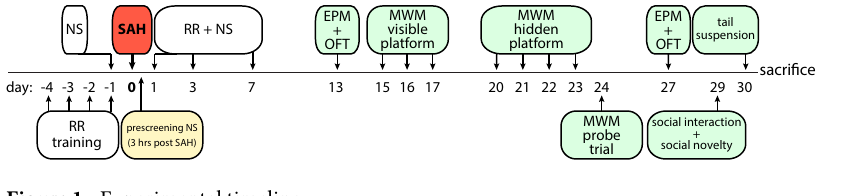
Figure 1. Experimental